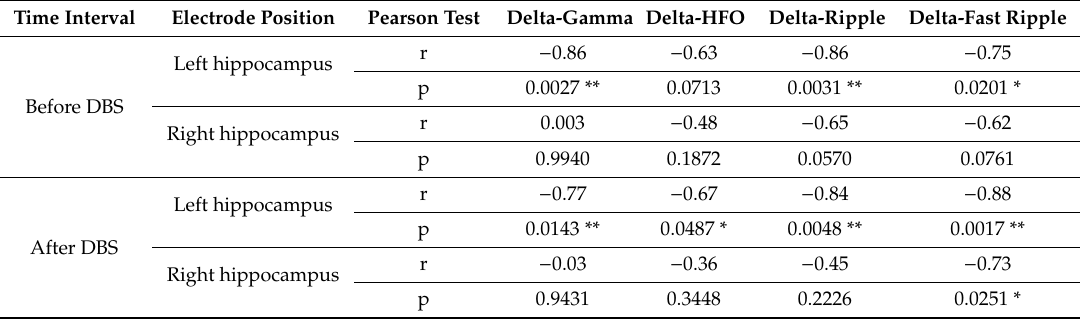
Figure 7. Maximum coupling strength between hippocampal delta and higher frequencies. All values are the average of 10 days. ( A ) Comparison of the coupling strength of control groups (SHAM-Control and DBS-Control together), DBS-Pilo Before and DBS-Pilo After in the left hippocampus. and ( B ) in the right hippocampus. Note that epileptic animals have significantly higher PAC values than controls. There is a global decrease after deep brain stimulation in PAC strength and every decrease is significant, except the delta-HFO PAC in the left hippocampus. Data were represented as mean ± SEM, * p < 0.05; ** p < 0.01; *** p < 0.001. Table 2. Correlation between change in seizure rate and PAC